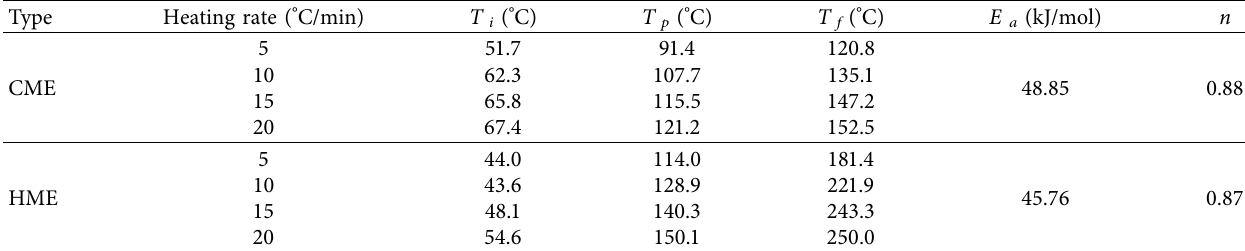
Figure 5: Fitting the curing curves of (a) CME and (b) HME based on the Kissinger equation. Table 6: Curing behavior of the CME and HME by differential scanning